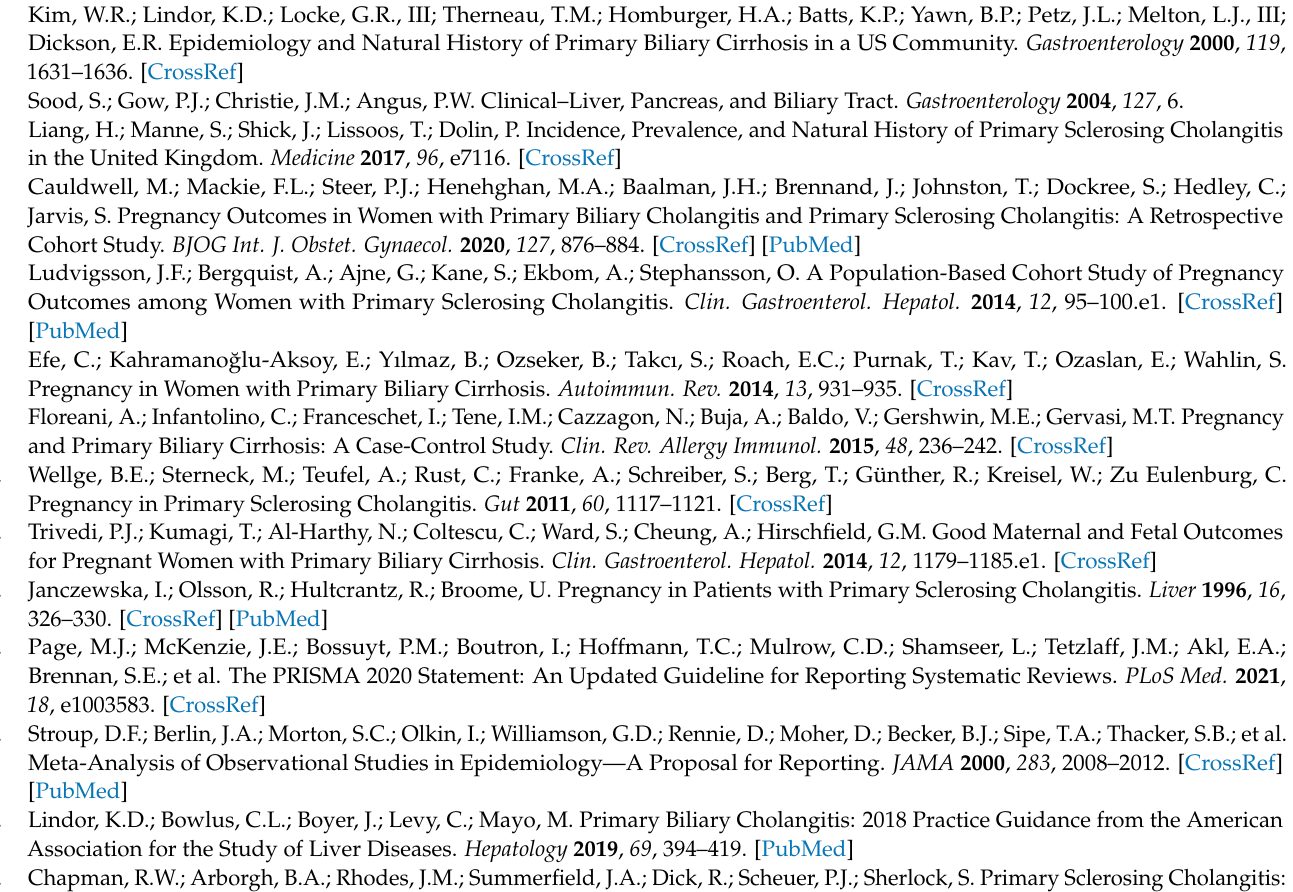
Appraisal Checklist for Case Series Studies, Table S7: GRADE assessment for fetal outcomes in PSC pregnancies, Table S8: GRADE assessment for fetal outcomes in PBC pregnancies, Table S9: GRADE assessment for pruritus in pregnant woman with PBC, Table S10: GRADE assessment for pruritus in pregnant woman with PSC, Table S11: GRADE assessment for Biochemical flare during postpartum in PBC and